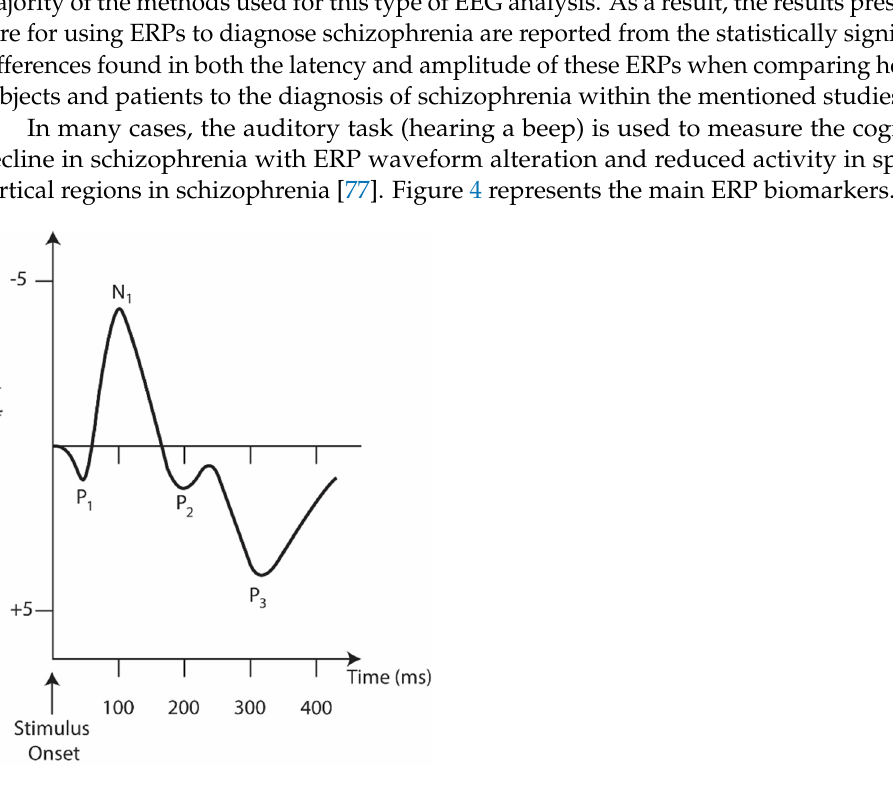
Figure 4. The idealized auditory ERP response is recorded at the head’s vertex. The y -axis is inverted where positive peaks are pointed downwards and negative peaks are pointed upwards.